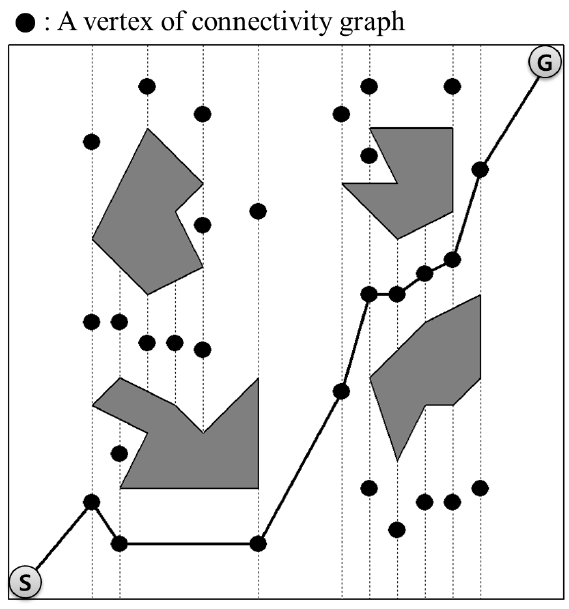
Figure 1. An example of Vertical Cell Decomposition (VCD) and its path.